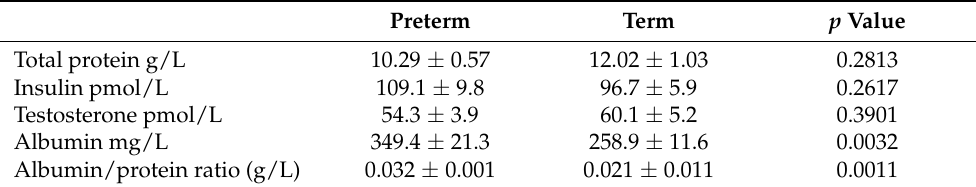
Table 2. Average concentration of total protein, insulin, testosterone, and albumin in preterm ( n = 114) and term ( n = 114) breast milk samples during the first 6 months of